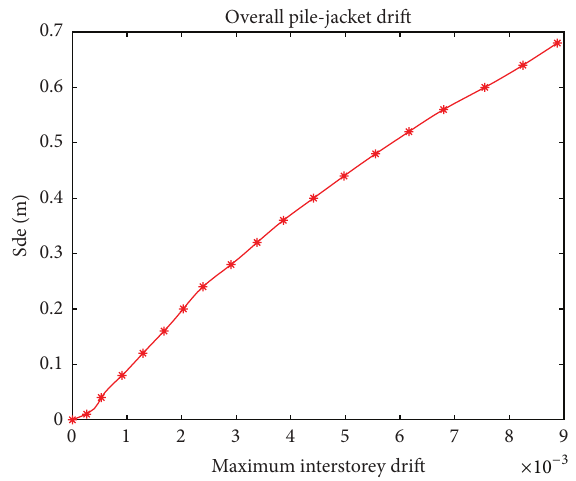
Figure 6: The overall drift ratio of the original platform from the pile tip up to the deck